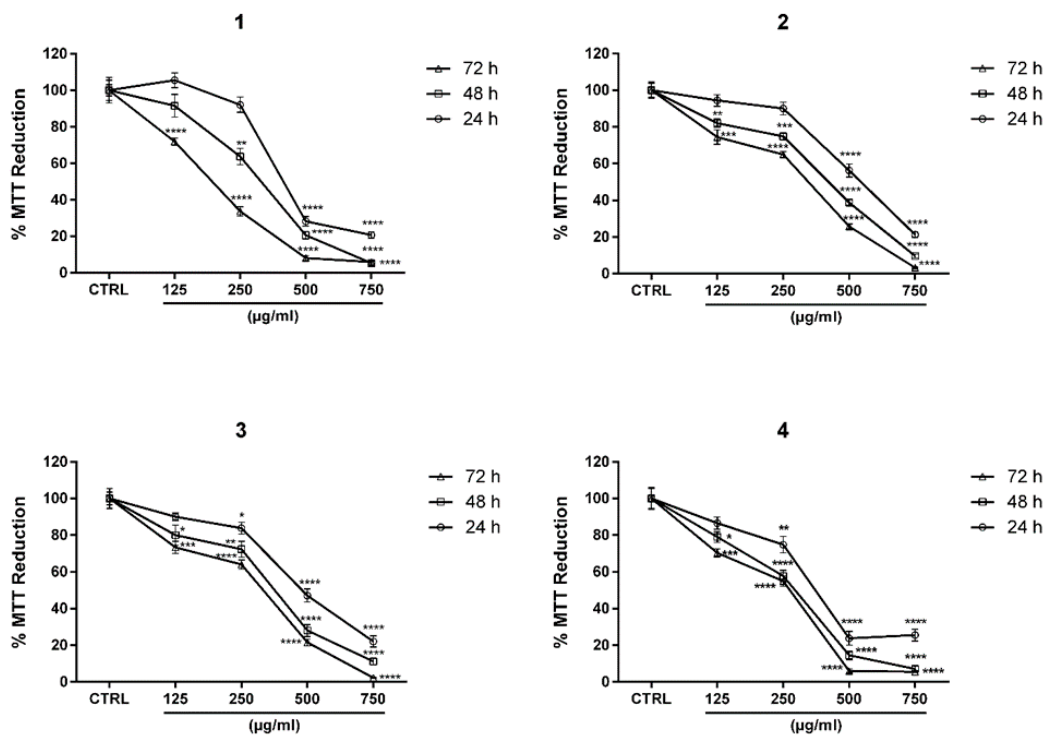
Figure 4. V. o ffi cinalis extracts reduce SH-SY5Y cell growth. The e ff ect on cell proliferation was Figure 4. V. officinalis extracts reduce SH-SY5Y cell growth. The effect on cell proliferation was evaluated by 3-(4,5-dimethylthiazole-2-yl)-2,5-diphenyltetrazolium bromide (MTT) assay. SH-SY5Y